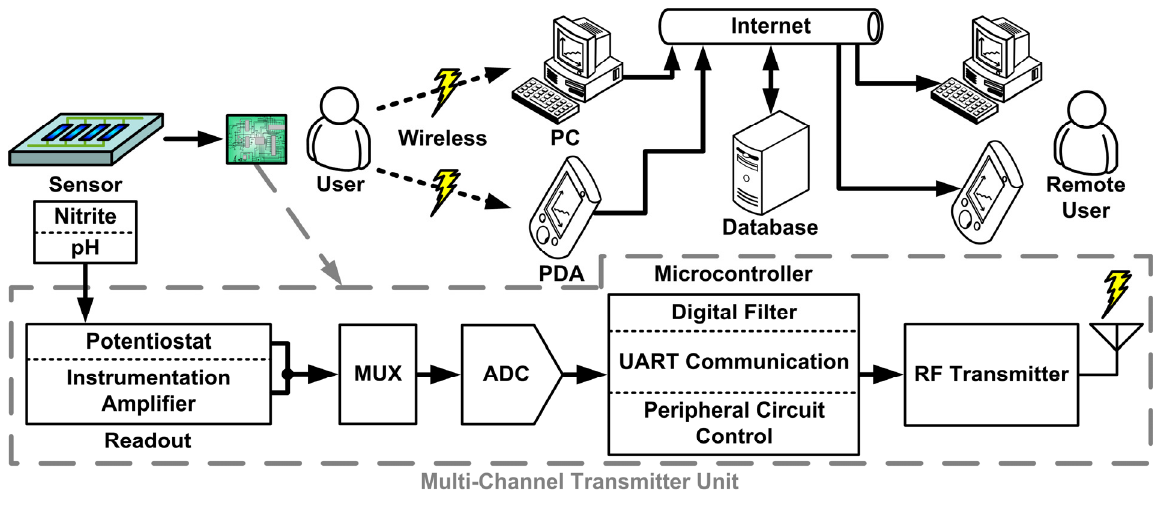
Figure 1. Block diagram of proposed real-time telemetry